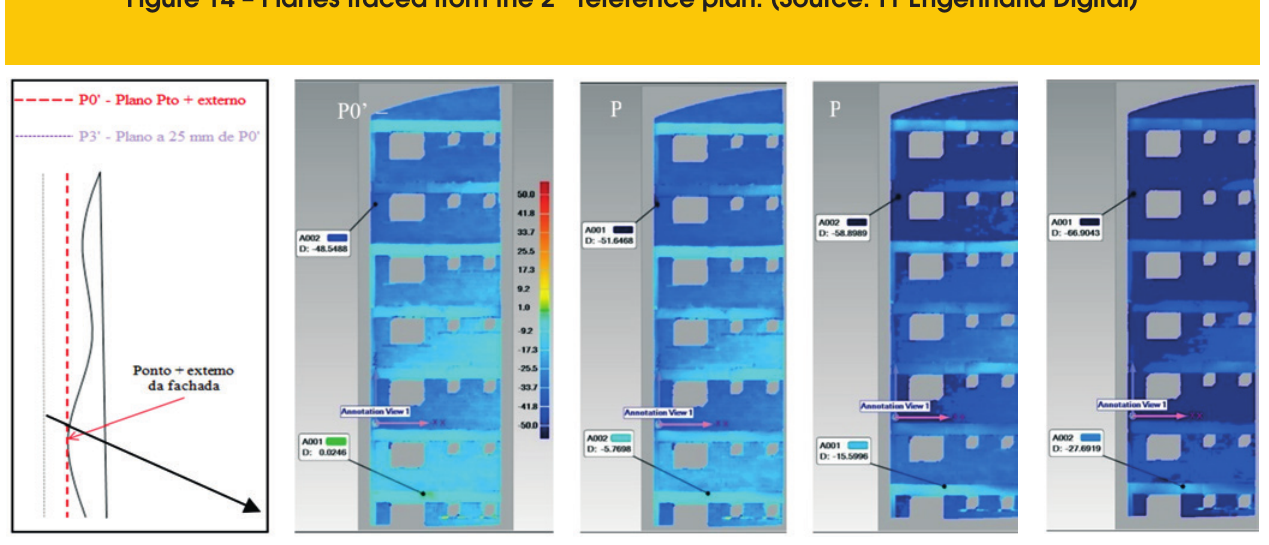
nd Figure 14 – Planes traced from the 2 reference plan. (Source: T1 Engenharia